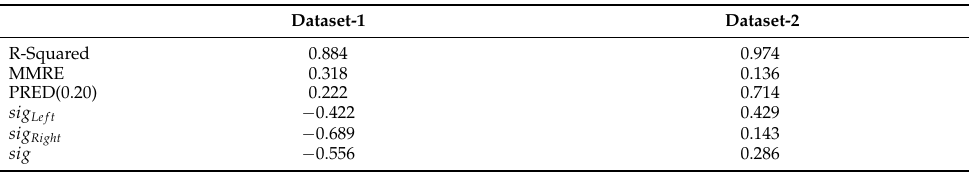
Table 5. Evaluation criteria obtained from